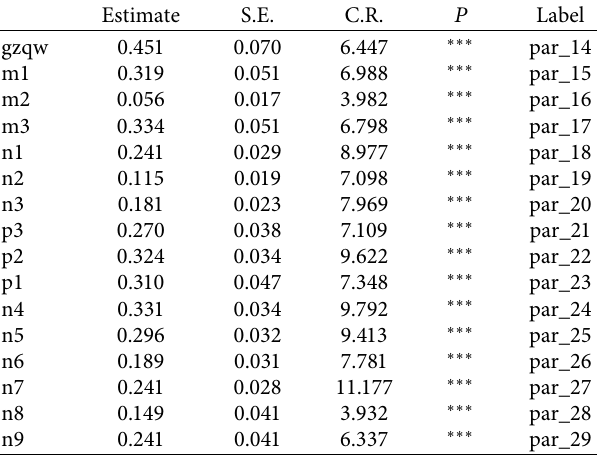
Table 10: Final variance estimates.